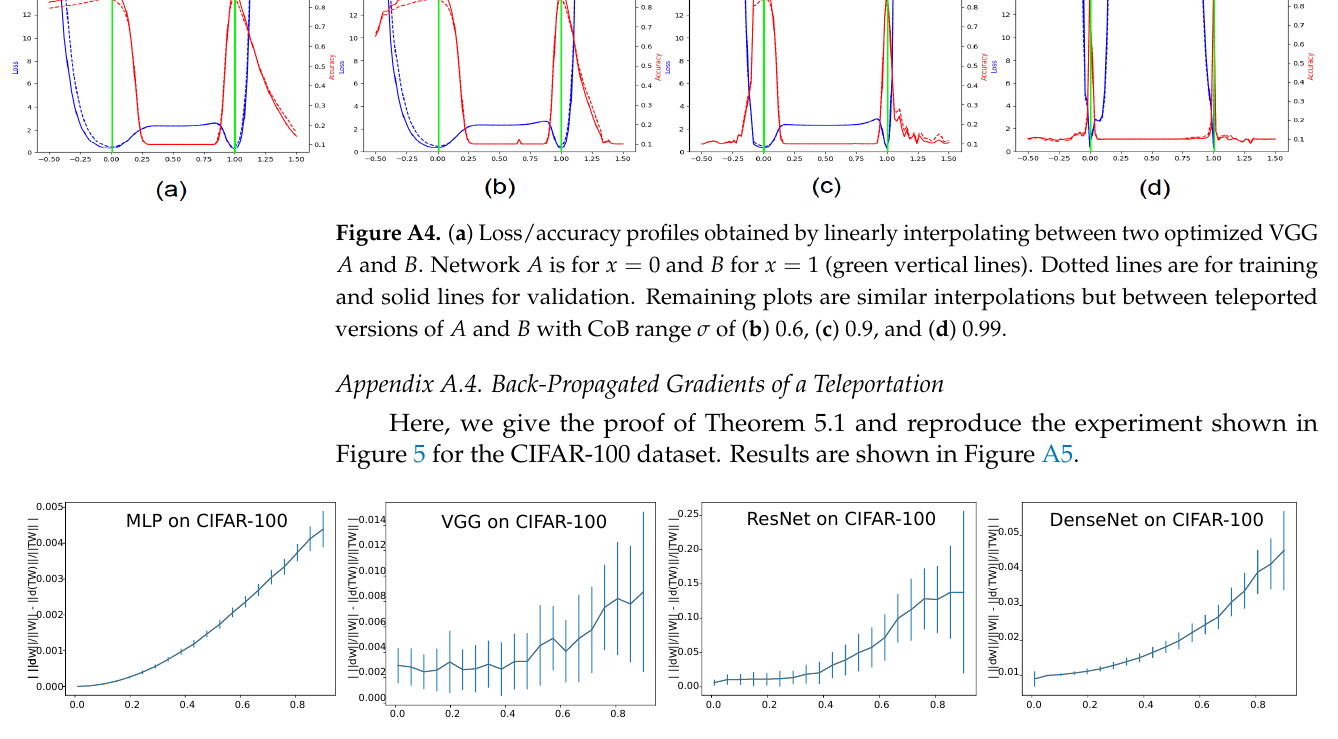
Figure A5. Mean absolute difference ( std-dev) between the back-propagated gradients’ magni- ± tudes of teleported networks and their original (non-teleported) network. Larger CoB generate larger